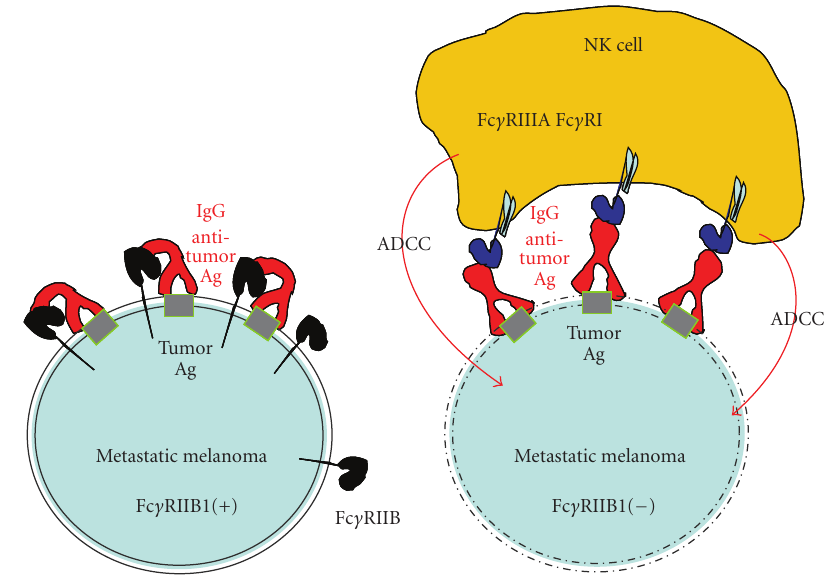
Figure 2: Tumor Fc γ RIIB1 expression protects metastatic melanoma from ADCC. Metastatic melanomas that express the Fc γ RIIB1 are resistant in vitro and in vivo in immunocompetent mice to the ADCC mediated by FcR γ chain dependent e ff ector cells (NK cells, neutrophiles monocytes, or macrophages). The tumor Fc γ RIIB1 are decoy receptors. The Fc portions of anti-tumor antibodies are captured by the tumor Fc γ RIIB1 and cannot interact with the Fc γ of the immune e ff ector